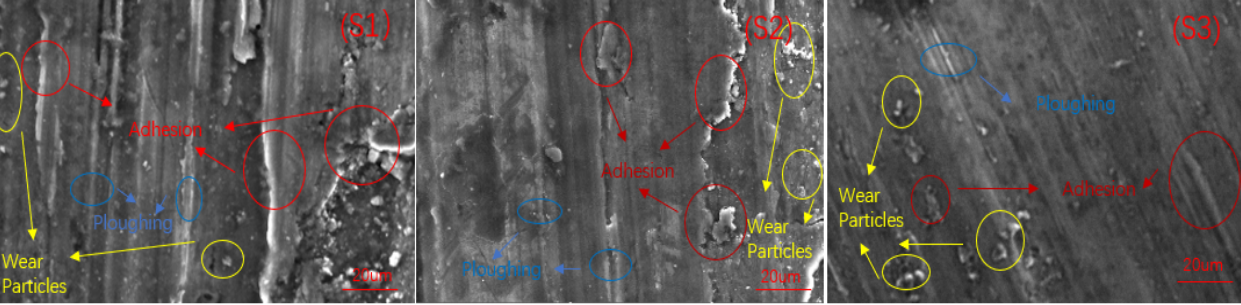
Figure 5. SEM images of worn morphologies of the (S1) primal sample; (S2) USRP sample; (S3) USRP + HELL sample.